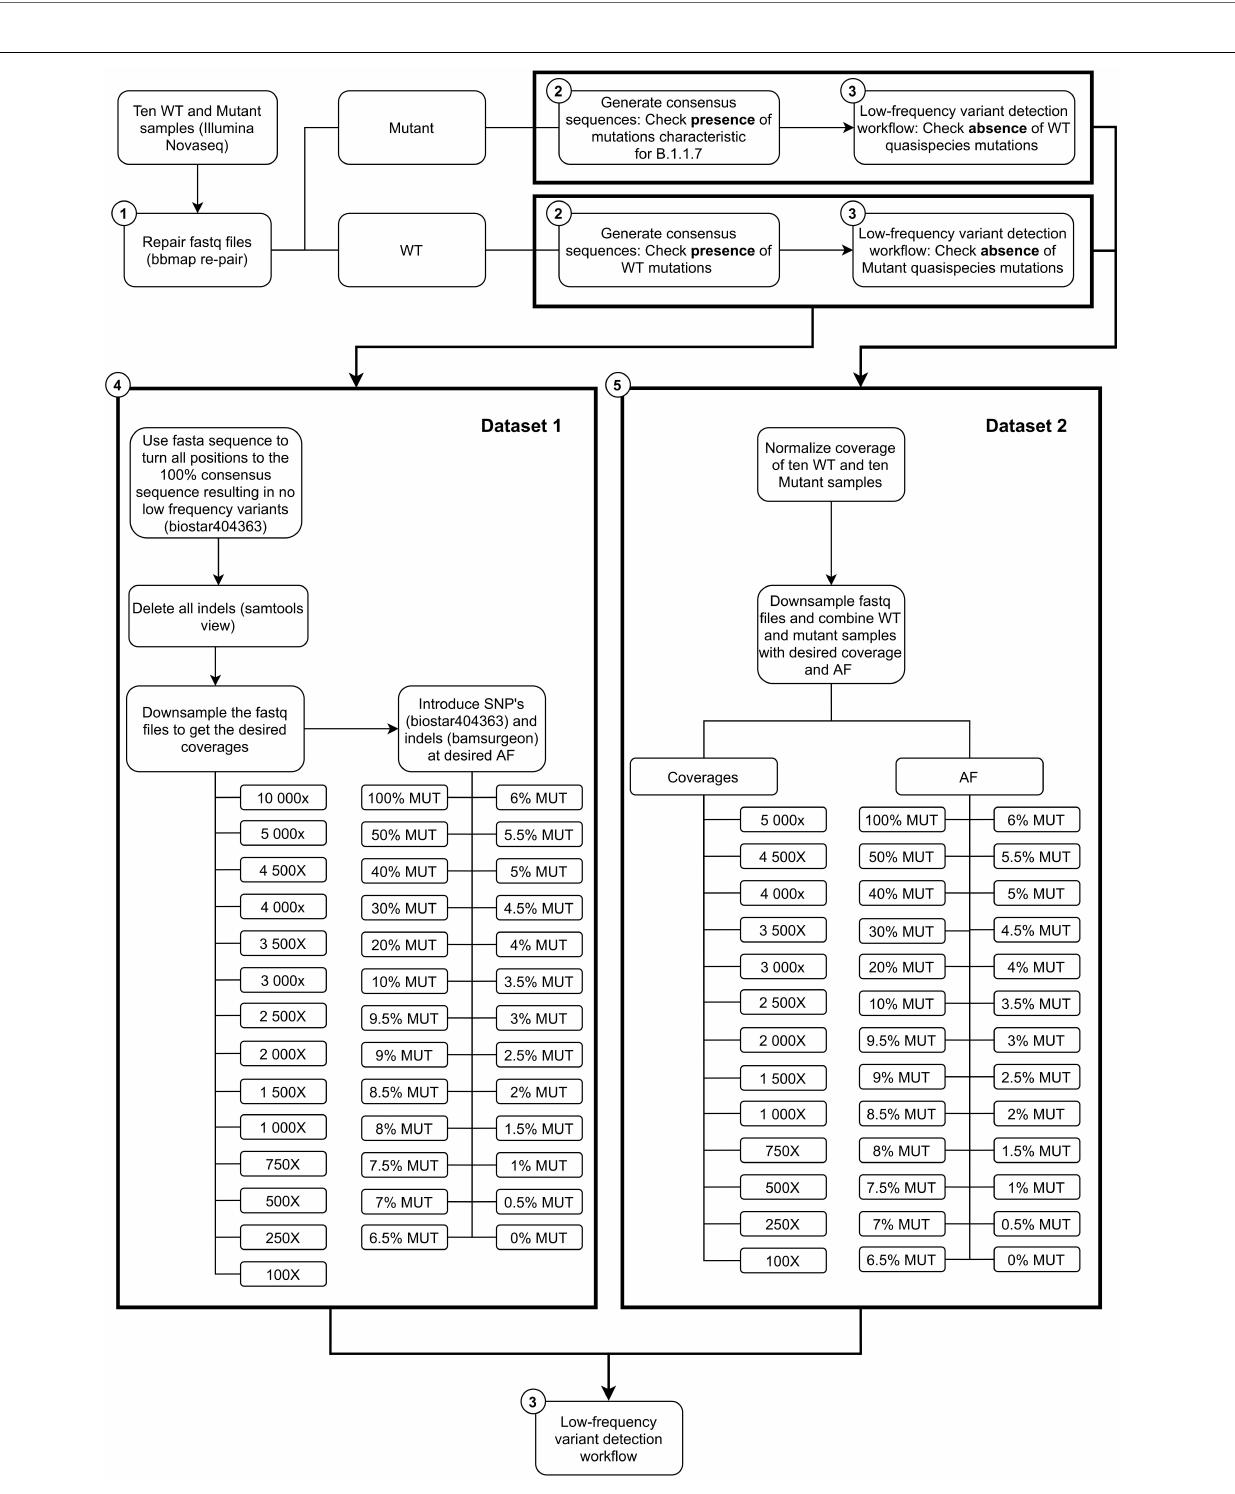
FIGURE 1 | Schematic representation of the